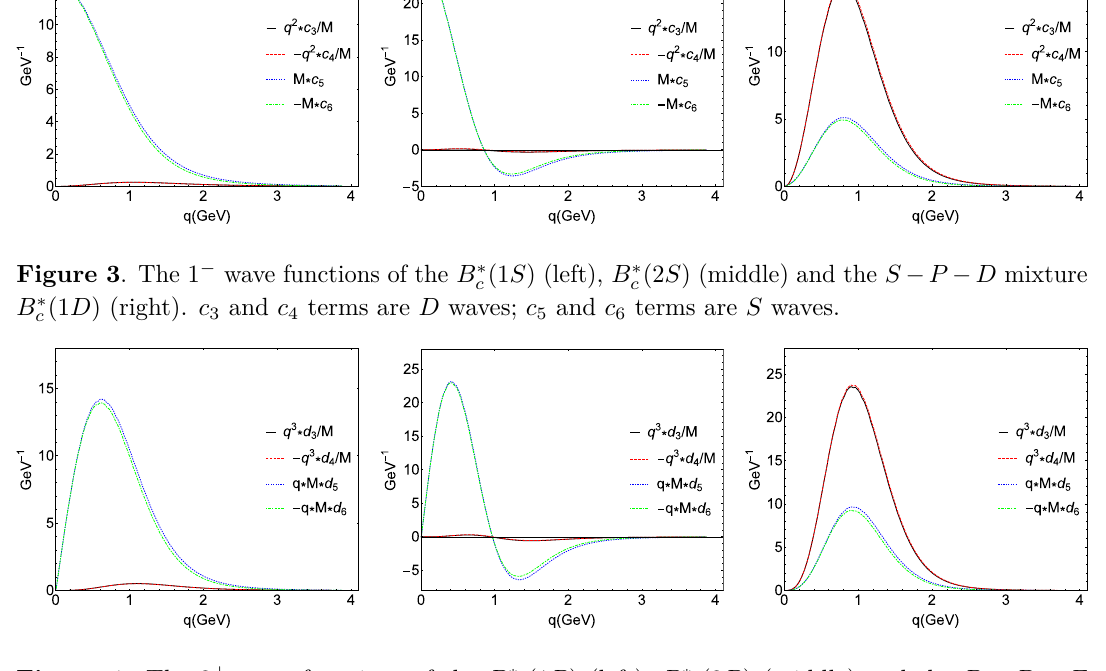
Figure 4 . The 2 + wave functions of the B ∗ mixture B ∗ (1 F ) (right). d 3 and d 4 terms are F waves; d 5 and d 6 terms are P c 2